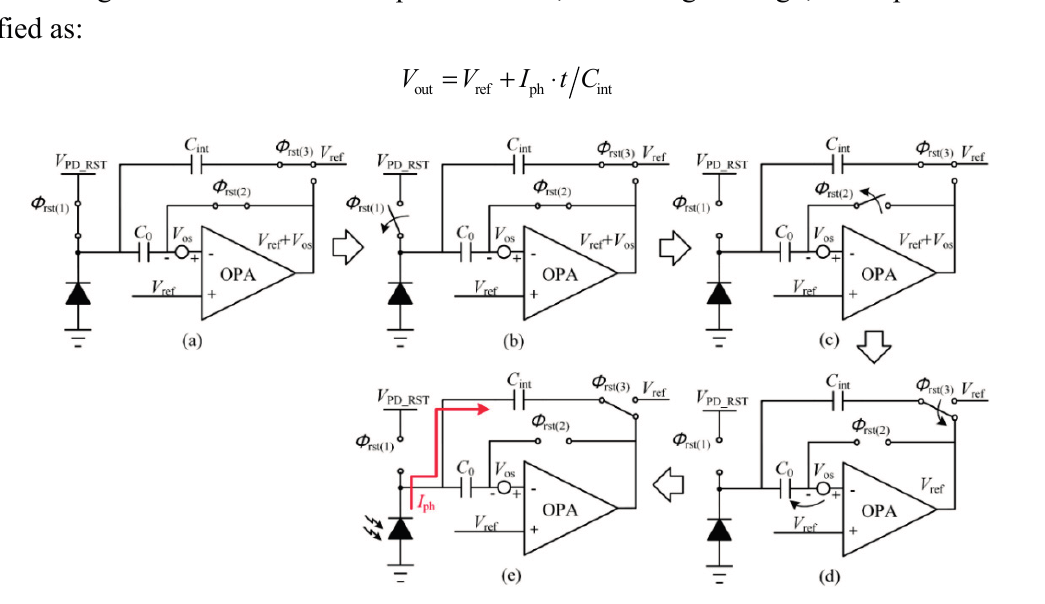
Figure 3. Switch sequence of the offset cancellation scheme. ( a ) Reset state; ( b ) ϕ rst(1) is switched off; ( c ) ϕ rst(2) is switched off; ( d ) ϕ rst(3) is switched from V ref to the output terminal; ( e ) I ph starts to integrate on C int